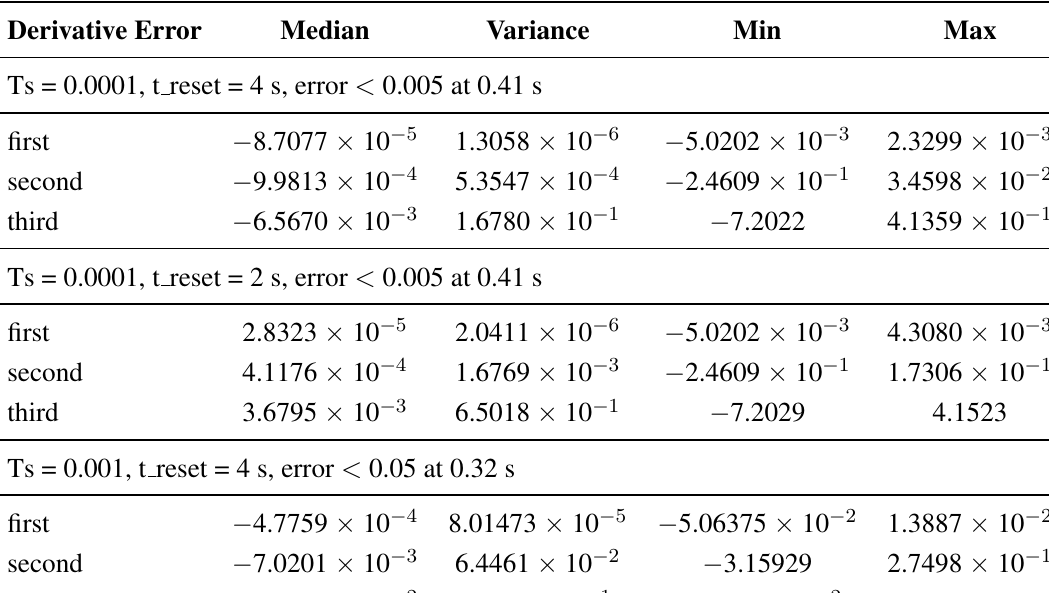
Table 1. Error analysis for the